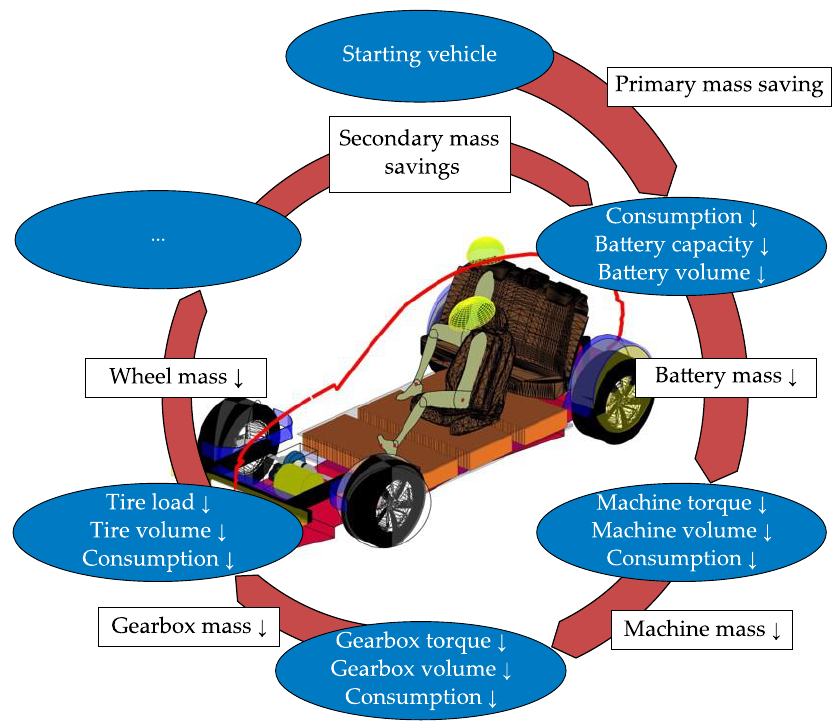
Figure 2. A mass spiral showing the SMSs generated from a lightweight measure. Based on [18].